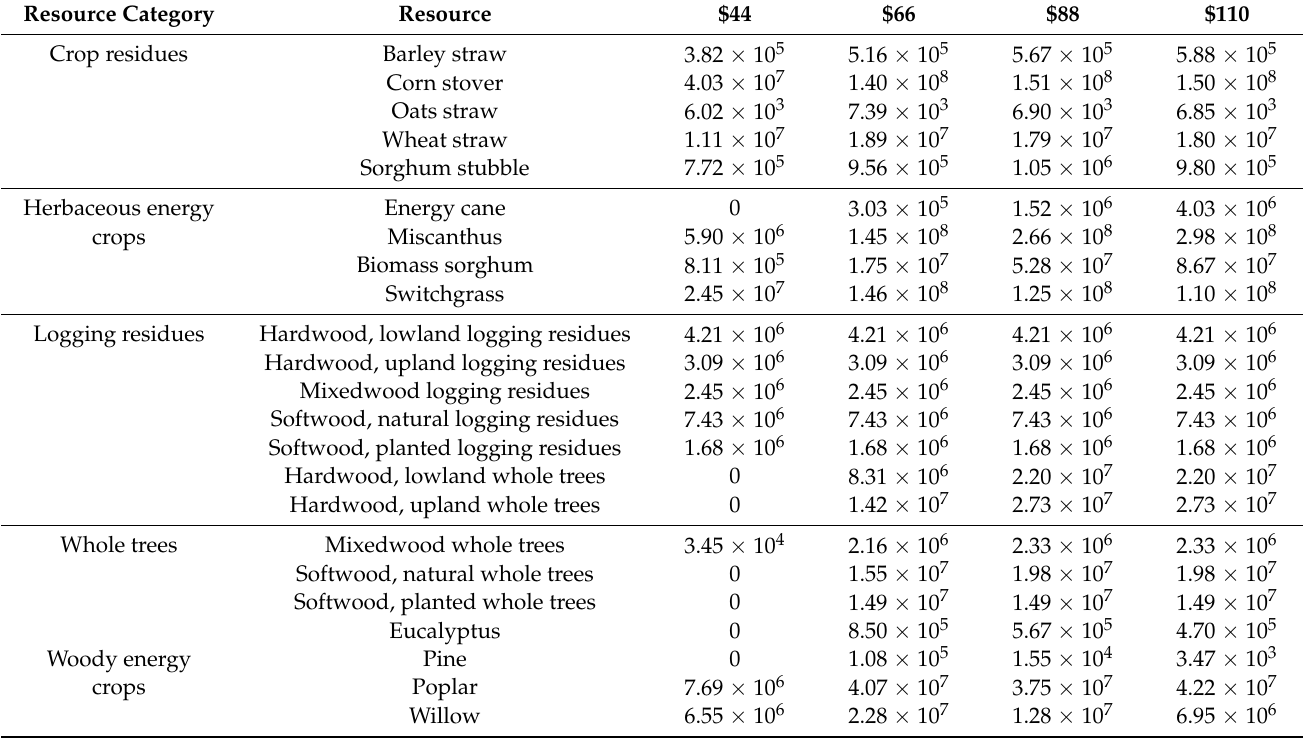
Table A7. Costs (inclusive of harvesting and handling) for fuels used in this study. These results serve as an input for the BILT model